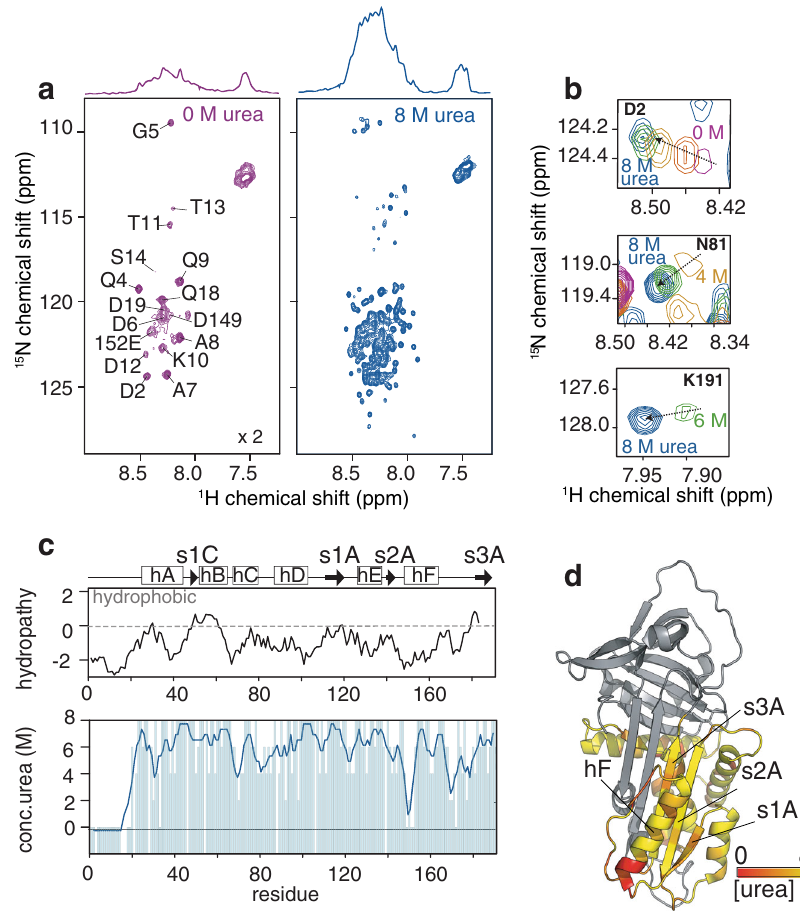
Fig. 4 NMR characterisation of the N-terminal fragment AAT-191. a (upper) 1D and (lower) 2D 1 H, 15 N-SOFAST HMQC spectra of the AAT-191 fragment in (left) 0 M and (right) 8 M urea, recorded at 25 °C and at a 1 H frequency of 950 MHz. b Selected AAT-191 resonances observed in increasing concentrations of urea. c (upper) A Kyte and Doolittle hydropathy plot for AAT-191 (lower) A plot depicting the urea concentrations at which non-proline residues are fi rst observable, and includes a 3-point moving average to highlight the extent of compaction observed across the sequence. d Mapped onto the AAT structure is a representation of AAT-191 depicting the regions that progressively unfold in 8 M urea and at which stage NMR resonances fi rst become observable ( c